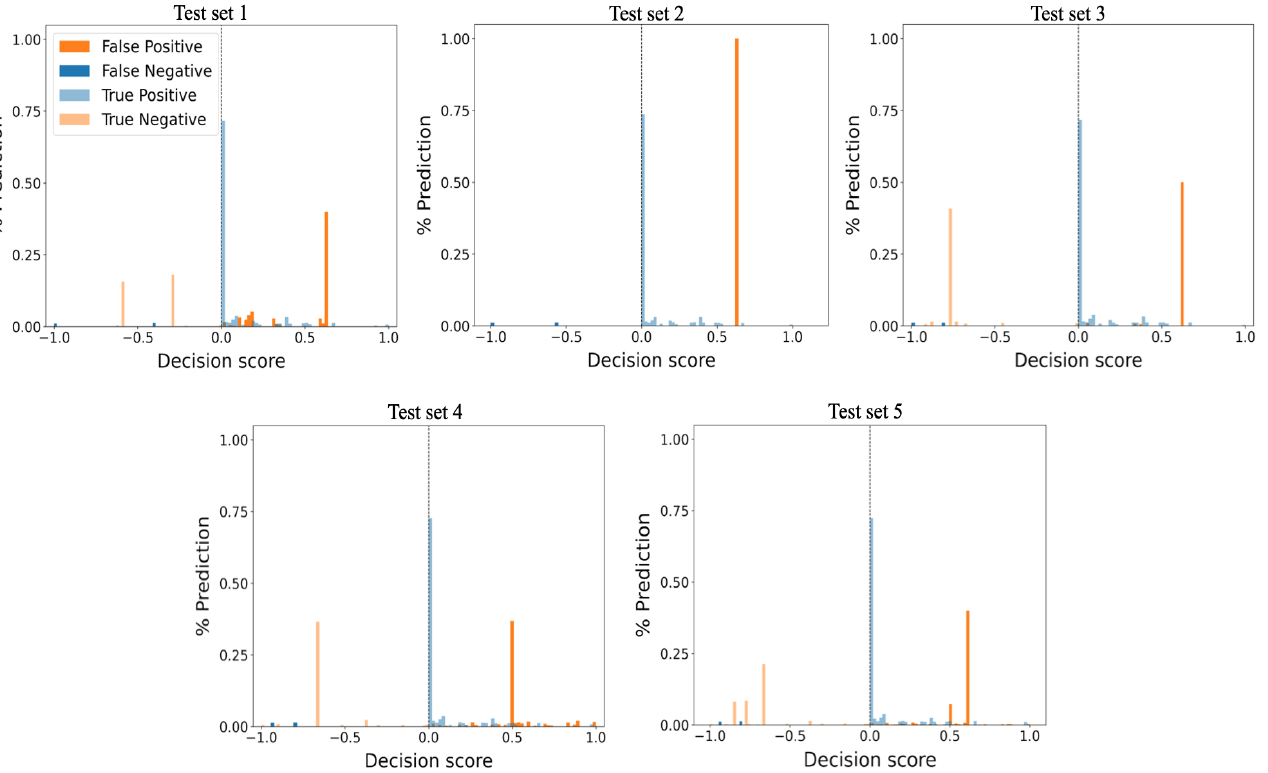
Figure 7. OCNN results of the normalized TP, TN, FP, and FN values on test sets 1–5.